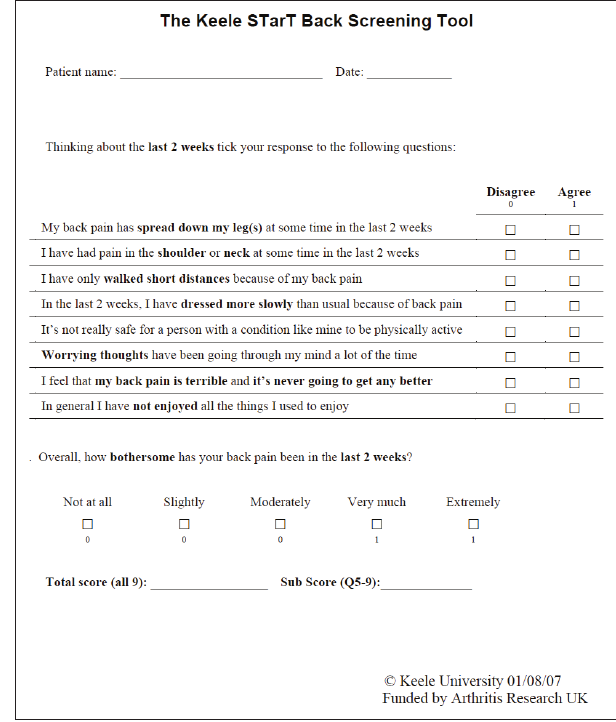
FIGURE 4: English STarT back screening tool.